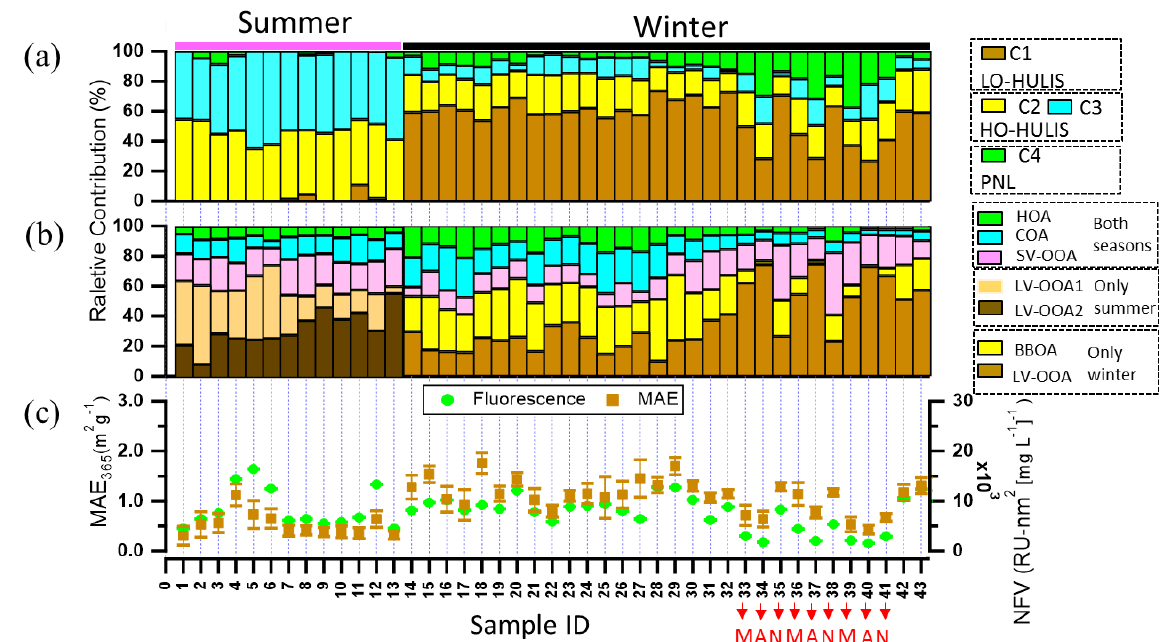
Figure 5. (a, b) Relative abundances of (a) the chromophore components, i.e. C1 is associated with less-oxygenated humic-like substances, C2 and C3 are associated with highly oxygenated HULIS, and C4 is associated with phenol- and naphthalene-like substance; (b) AMS-PMF factors, i.e. HOA, COA, SV-OOA, and LV-OOA1 for both seasons, LV-OOA2 only in summer, and BBOA and LV-OOA only in winter; and (c) the normalized fluorescence volume (NFV) (normalized to organic aerosol concentration) and mass absorption efficiency at 365nm (MAE365). Sample IDs 1–13 in summer and Sample IDs 14–43 in winter. Sample IDs 33, 36, and 39 in the morning (M); Sample IDs 34, 37, and 40 in the afternoon (A); Sample IDs 35, 38, and 41 at night (N). Sample IDs 1–32 and 42–43 for the whole